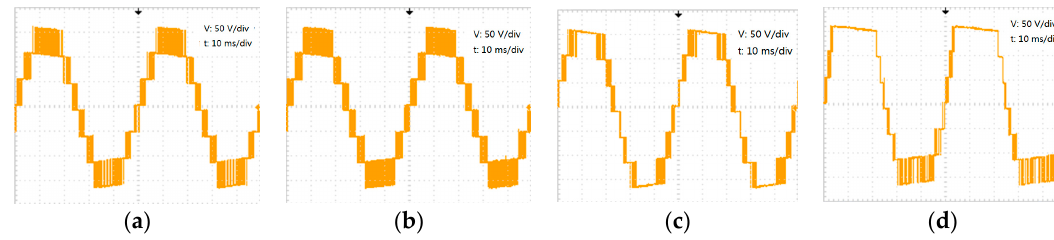
Figure 23. Phase voltage of 7-level inverter with different PWM schemes, ( a ) IPDPWM; ( b ) PSPWM; ( c ) classical SVPWM; ( d ) proposed SVPWM.